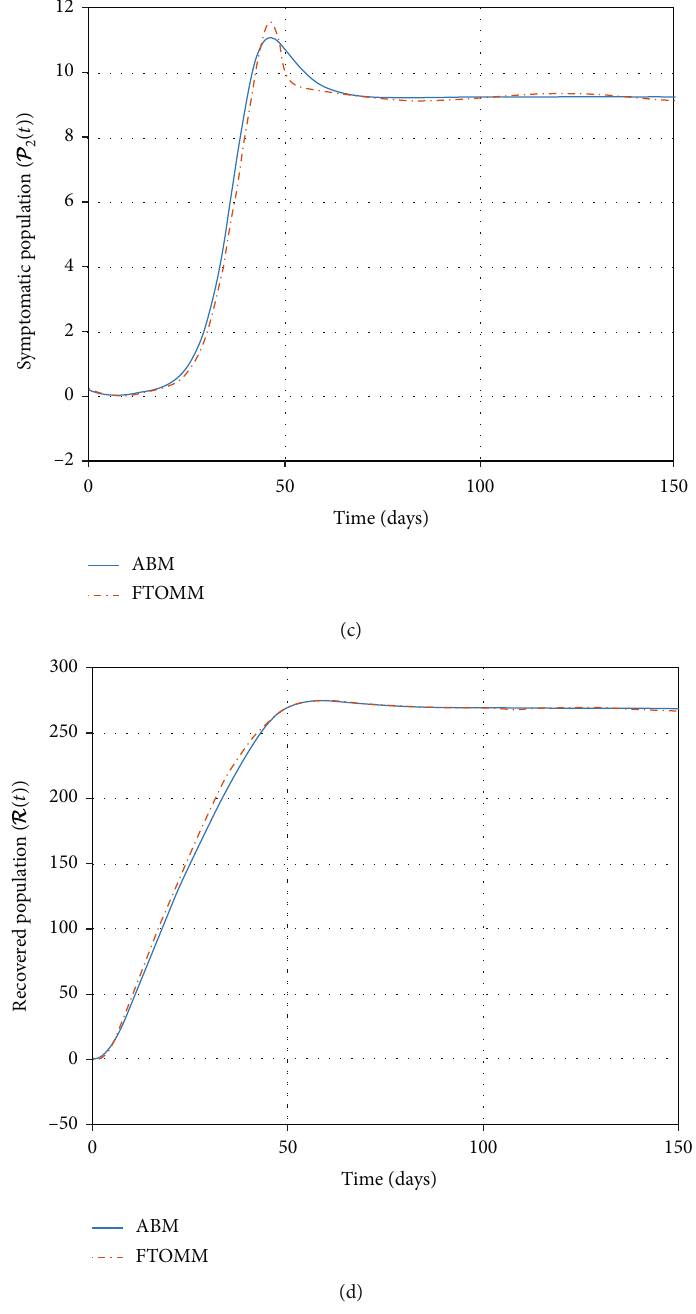
Figure 8: Comparisons between the ABM and FTOMM for the parametric